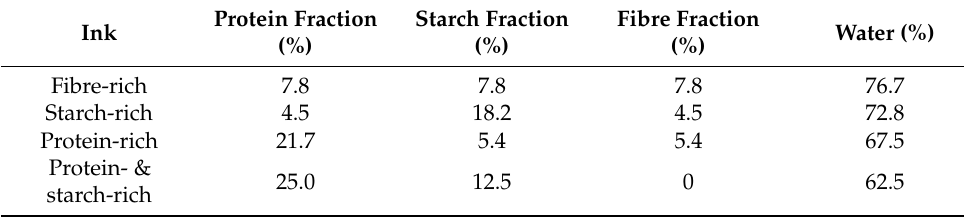
Table 1. Composition of the different inks used for 3D